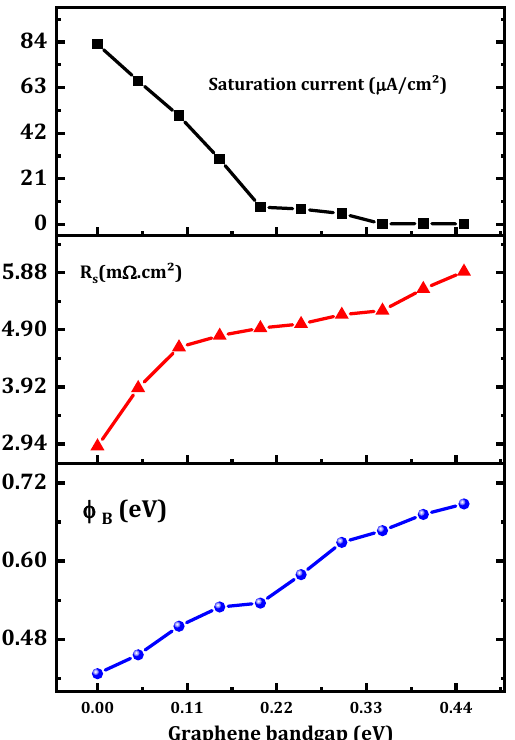
Figure 5. Output J—V variations with the graphene bandgap.